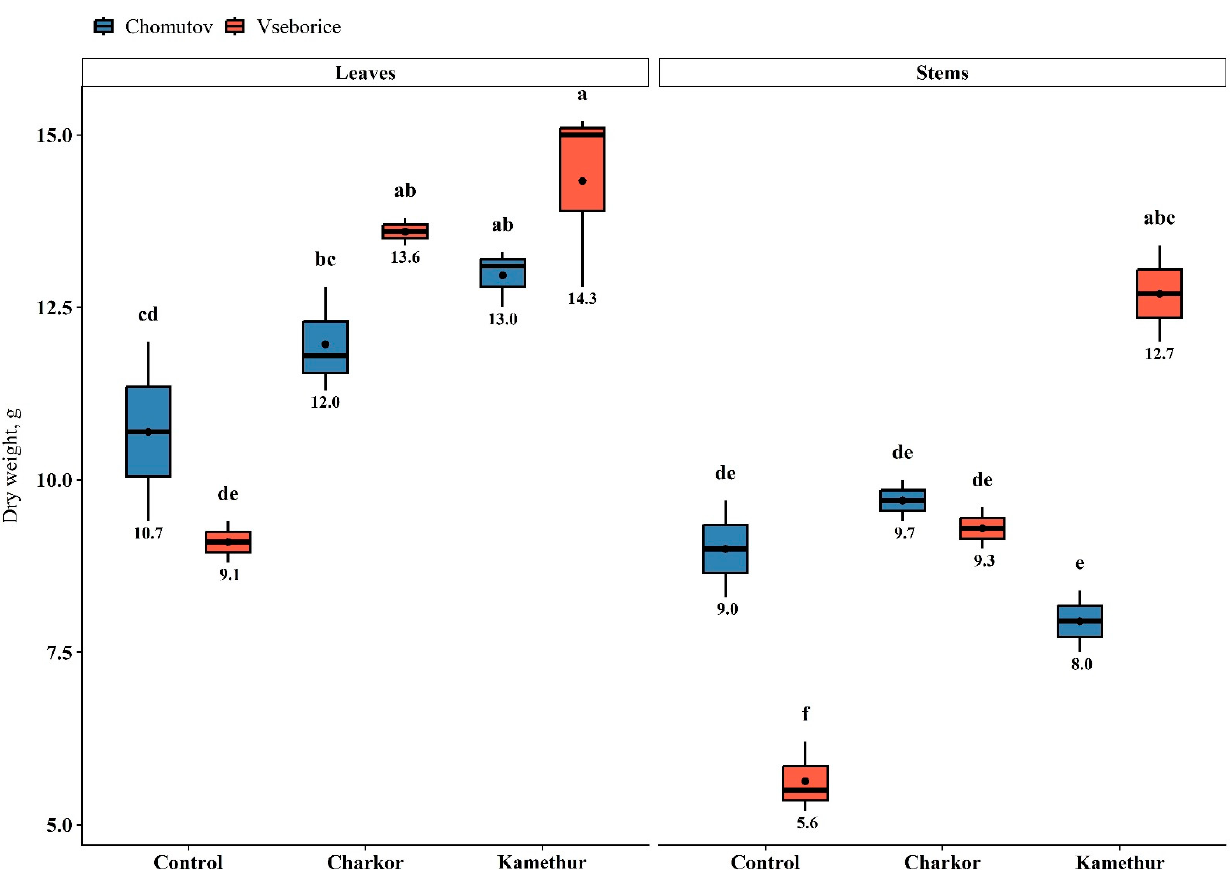
Figure 4. Leaves and stem’s DW of M × g grown in the Chomutov and Všeboˇrice soils. Different letters indicate a significant difference between the values ( p < 0.001).